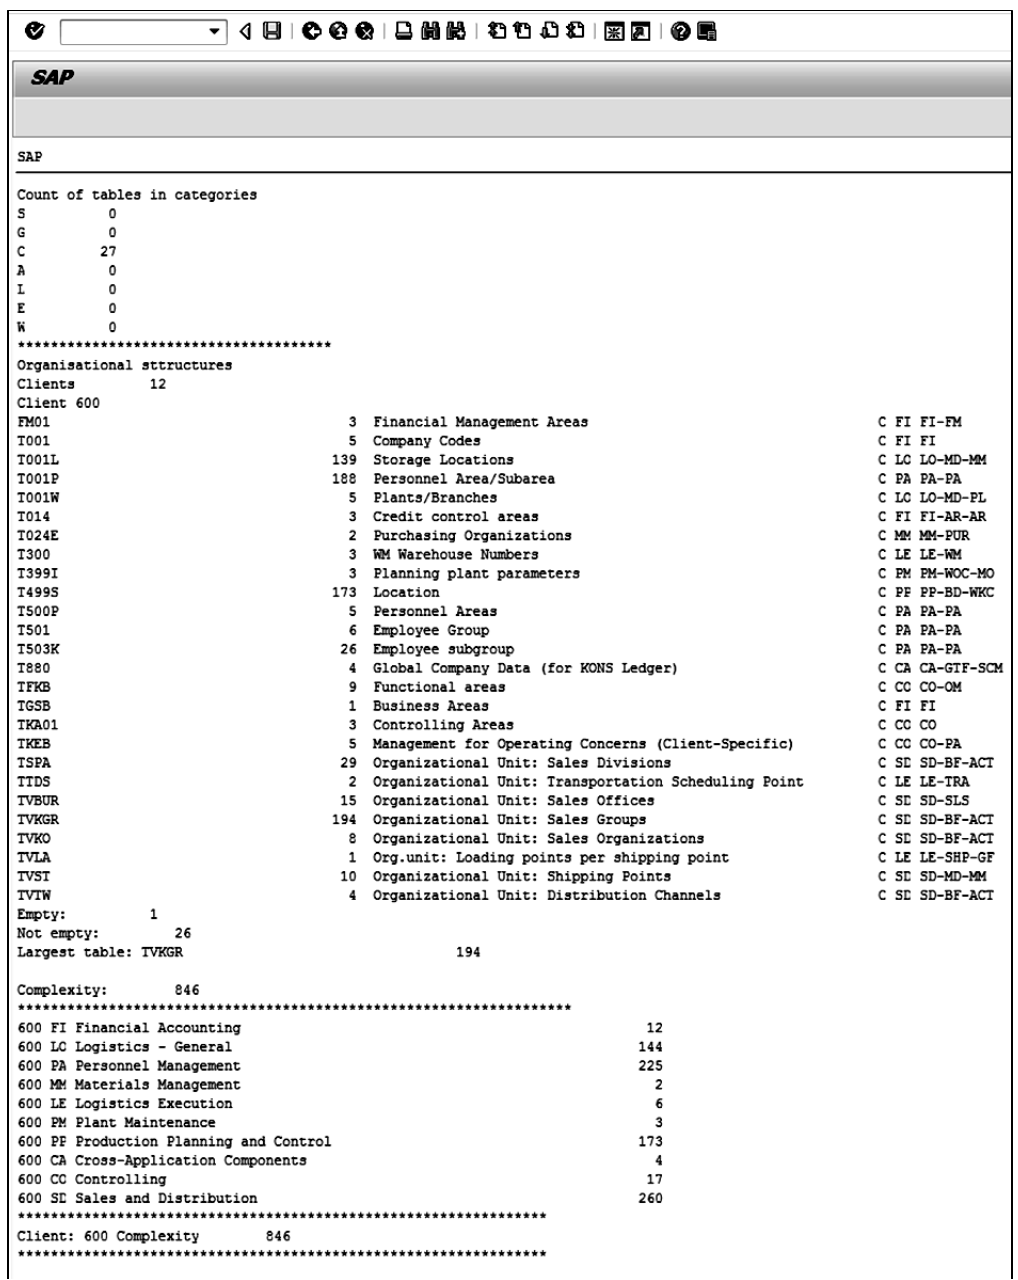
Figure 2. Output of the Identify High Complexity program